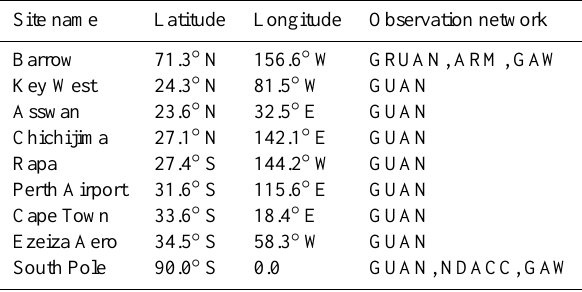
Table 3. Proposed measurement sites for the detection of 21st cen- tury temperature trends at the lower